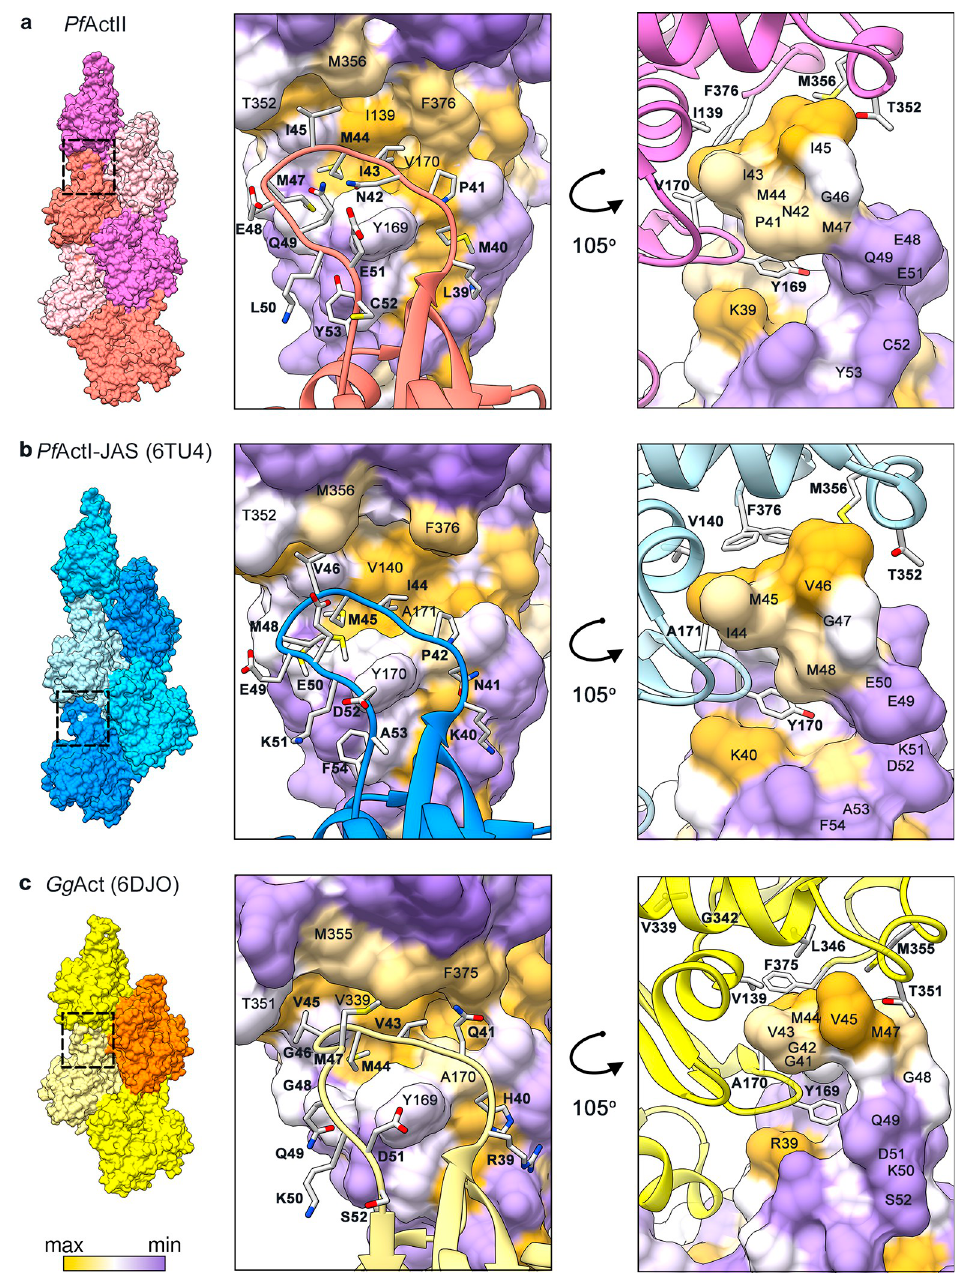
Fig 3. Interaction of the D-loop with the adjacent protomer. (a) P . falciparum actin II, (b) actin I-JAS (6TU4), (c) skeletal muscle α -actin from G . gallus (6DJO). The actin surface is colored according to hydrophobicity; high (yellow), medium (white), and low